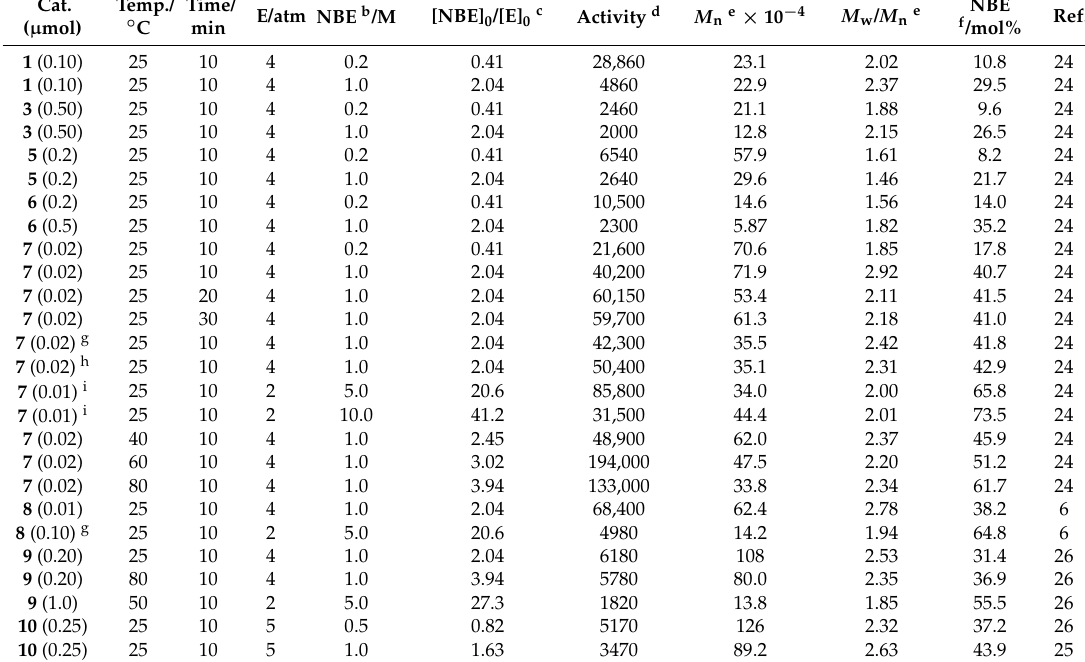
Table 1. Copolymerization of ethylene (E) with norbornene (NBE) by [Me 2 Si(indenyl) 2 ]ZrCl 2 ( 1 ), [Me 2 Si(C 5 Me 4 )(N t Bu)]TiCl 2 ( 3 ), Cp’TiCl 2 (O-2,6- i Pr 2 C 6 H 3 ) (Cp’ = C 5 Me 5 (Cp*, 5 ), indenyl ( 6 )), Cp’TiCl 2 (N=C t Bu 2 ) (Cp’ = Cp ( 7 ), t BuC 5 H 4 ( 8 )), CpTiCl 2 [1,3- t Bu 2 (CHN) 2 C=N] ( 9